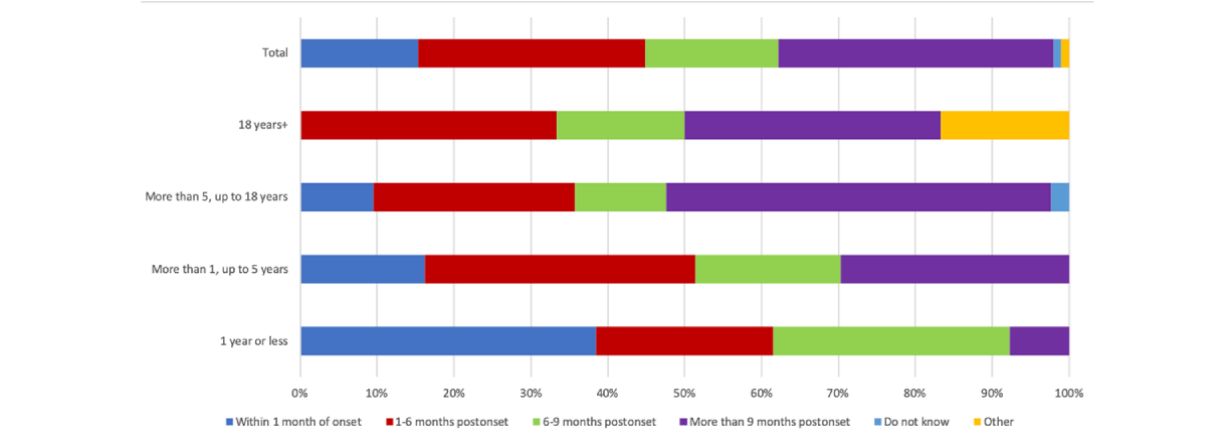
Figure 2. Timing of referral for tailored facial exercise therapy following onset of